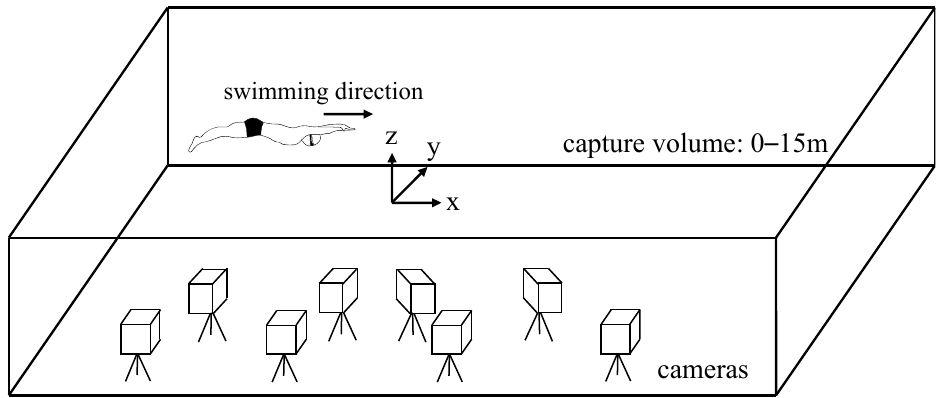
Figure 1. The experimental setup for the data collection.